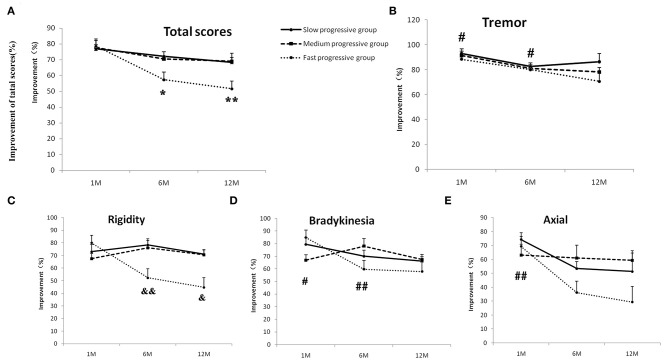
The outcomes of bilateral STN-DBS at stimulation onset (1 month) and 6 and 12 months in the slow-, medium-, and fast-progression groups. The effect of bilateral STN-DBS on the total motor scores (A), resting tremor scores (B), rigidity scores (C), bradykinesia scores (D), and axial scores (E) assessed by UPDRS-III in the three different groups. There are interaction effects between times and groups for total scores and rigidity scores. The post hoc test with Bonferroni correction indicated that the improvements of total motor function at the 6th and 12th months are significantly lower than that of the first month in the fast-progression group (A), and the improvements of rigidity in the fast group are lower than in the slow-progression groups at 6th and 12th months (C). There were no interaction effects between time and group on the resting tremor, bradykinesia, and axial scores. The post hoc test with Bonferroni correction indicated that the improvements of tremor and bradykinesia scores in the 12th month are lower than in the 1st and 6th months (B,D). The improvement in axial tremor in the 12th month was lower than in the first month (E). “*”/“**” indicates a significant difference from the first month in the fast-progression group, p < 0.05/0.01, respectively, “#” indicates a significant difference between the improvement of the 1st/6th and 12th months, p < 0.05/0.01. “&” indicates a significant difference between the improvement in the fast- and slow-progression groups, p < 0.05/0.01.